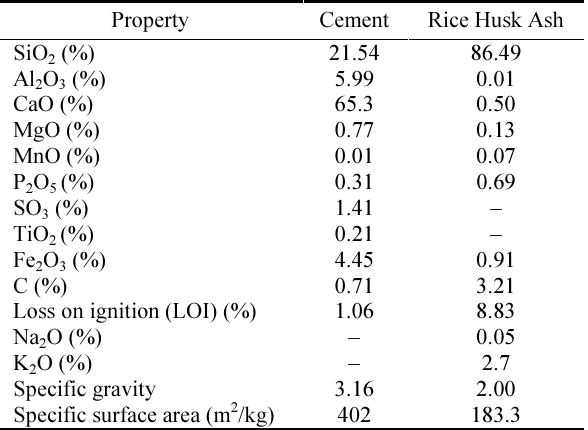
Table 1. Chemical and physical properties of cement and rice